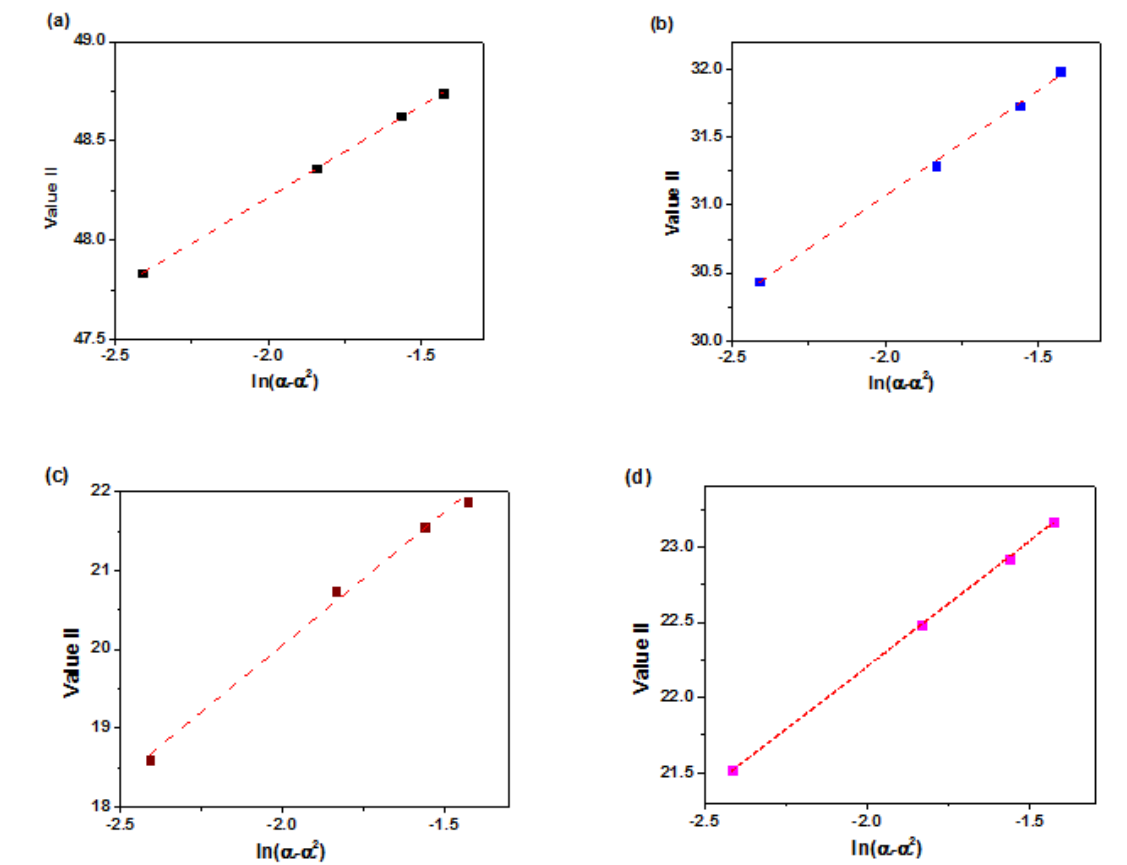
Figure 11. Plots of ValueII calculated using DSC data for ( a ) neat epoxy, ( b ) epoxy/P-HNT, ( c ) epoxy/A-HNT and ( d ) epoxy/F-HNT.